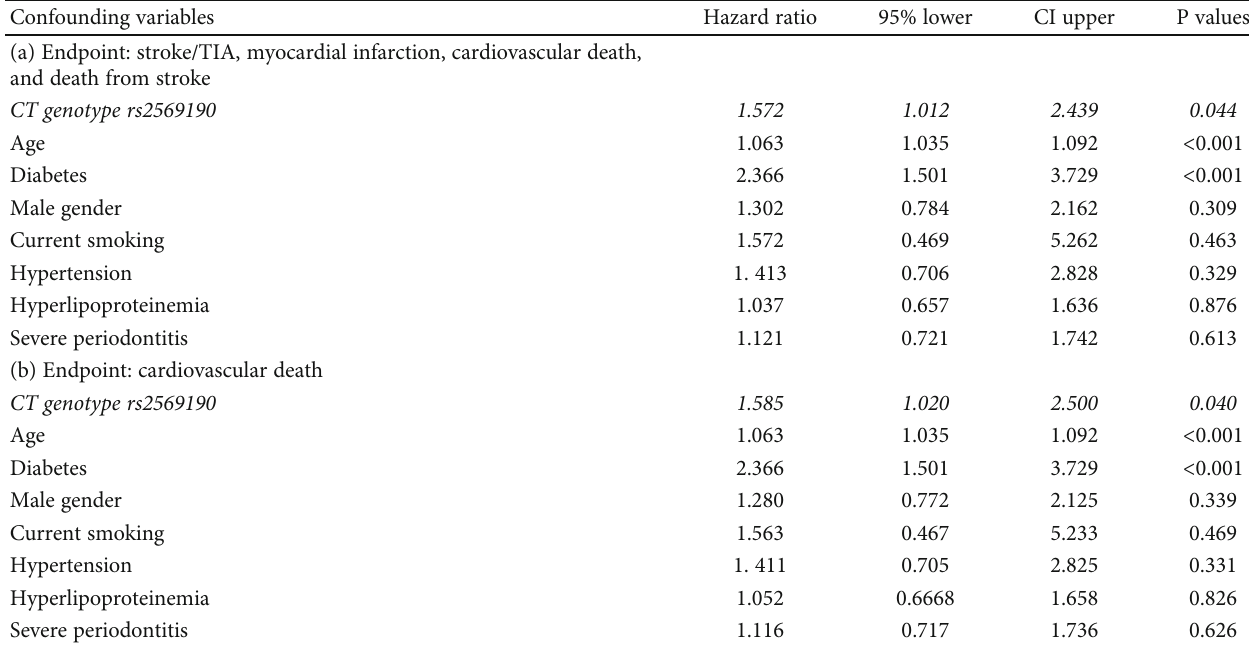
Figure 1: Kaplan-Meier plot for the incidence of the (a) combined endpoint (stroke/TIA, myocardial infarction, cardiovascular death, and death from stroke) and (b) cardiovascular death within a 3-year follow-up period according genotype distribution of CD14 SNP rs2569190. Statistical comparison was made by the log-rank test. Table 5: Cox regression analysis evaluating the hazard ratio (HR) of the CT genotype of CD14 SNP rs2569190 for the incidence of the (a) combined endpoint (stroke/TIA, myocardial infarction, cardiovascular death, and death from stroke) and (b) cardiovascular death within a 3-year follow-up period (adjusted for age, gender, smoking, body mass index, hypertension, hyperlipoproteinemia, diabetes, and severe